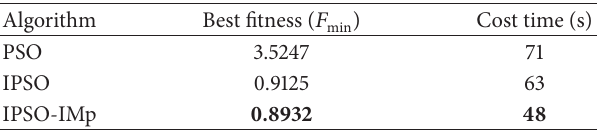
Table 3: Comparison of different optimization algorithms. Algorithm